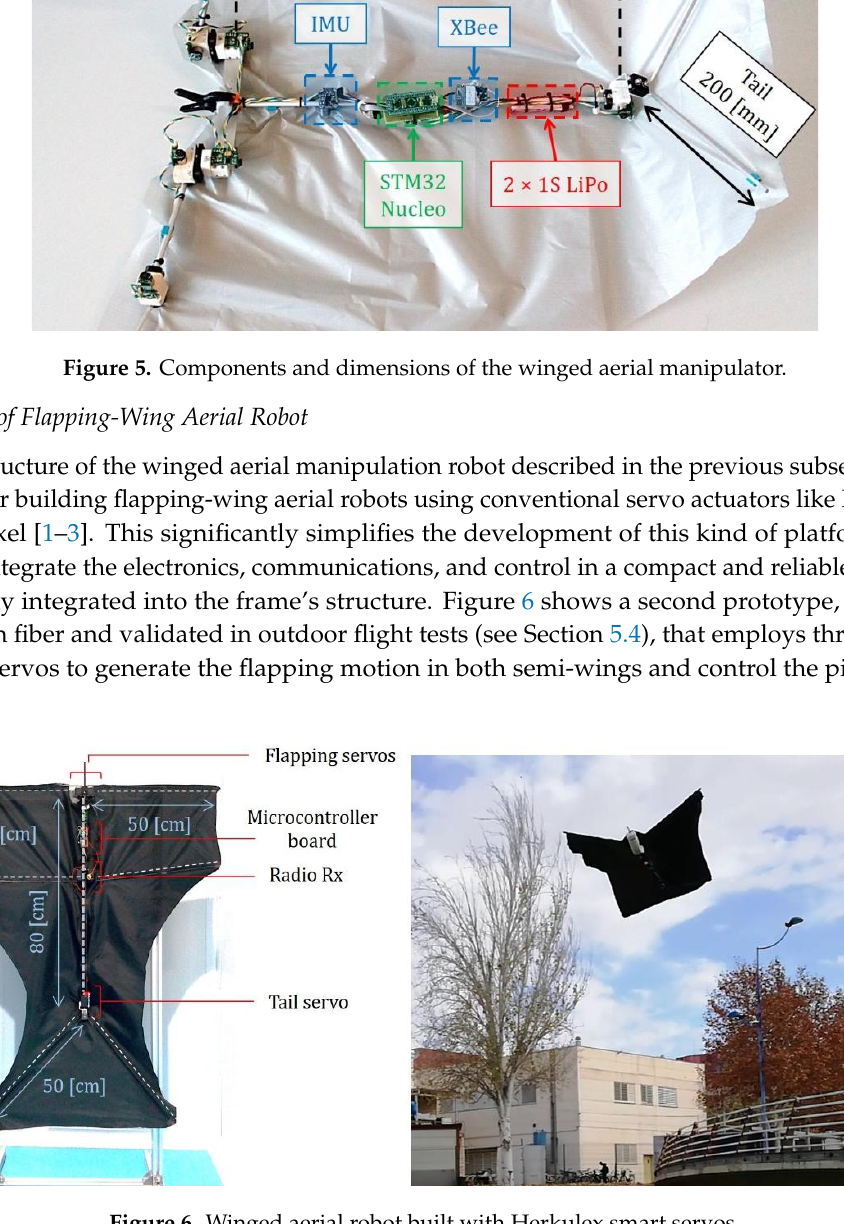
Figure 6. Winged aerial robot built with Herkulex smart servos.